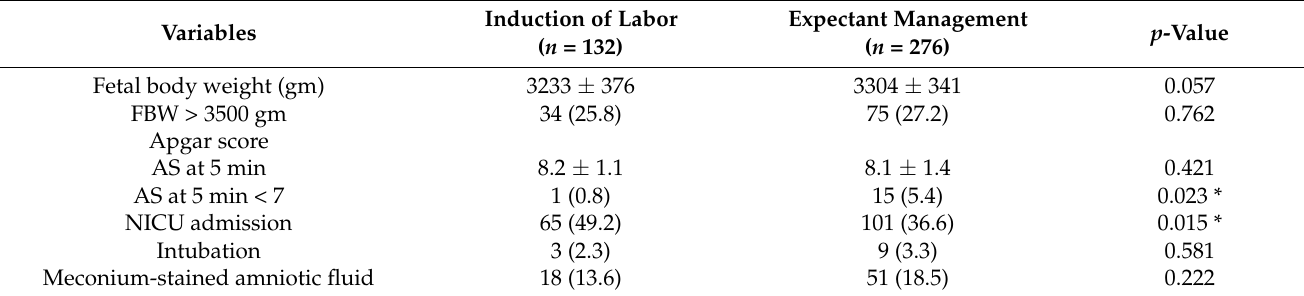
Table 3. Neonatal outcomes of induced labor and expectant